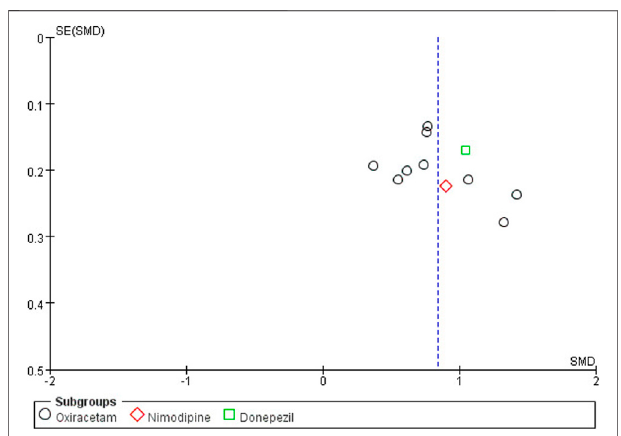
FIGURE 12 | Funnel plot of the MoCA score of NBP as combination